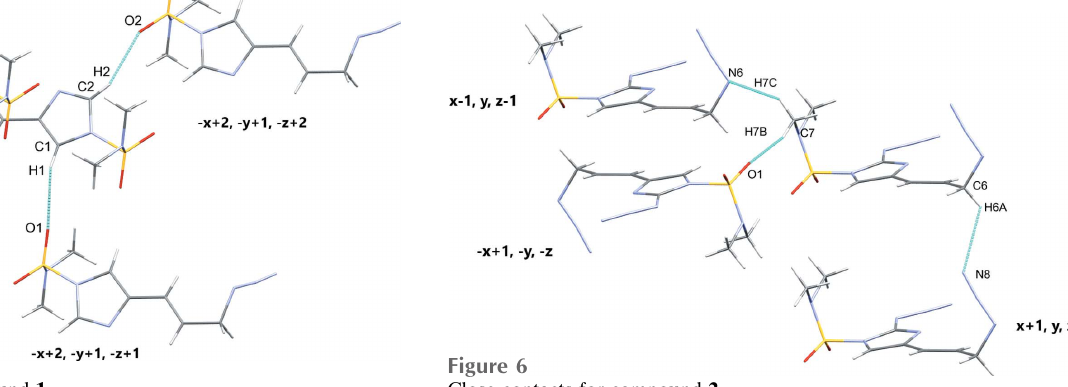
Figure 6 Close contacts for compound 2